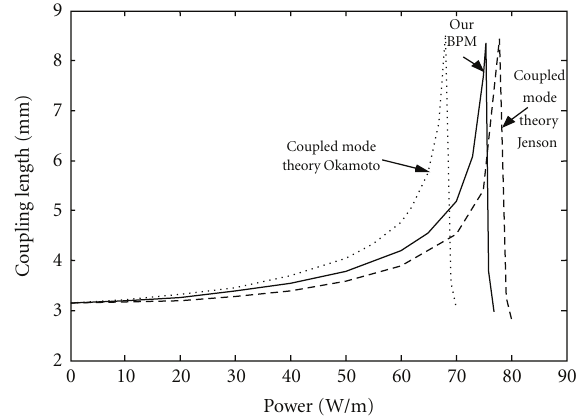
Figure 3: Power versus coupling length. Line properties are same as in Figure